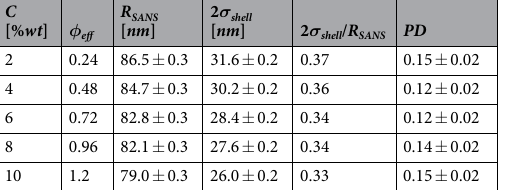
Table 3. Summary of the properties of the Hm-Dm mixture of microgels obtained from SANS experiments under ZAC conditions at all concentrations investigated. Shown are the number-averaged values of the overall radius R SANS = R + 2 σ shell , the fuzzy shell 2 σ shell , the size ratio 2 σ shell / R SANS , and the polydispersity PD as obtained from a fit of the fuzzy sphere model to the experimental data for T = 27 °C.